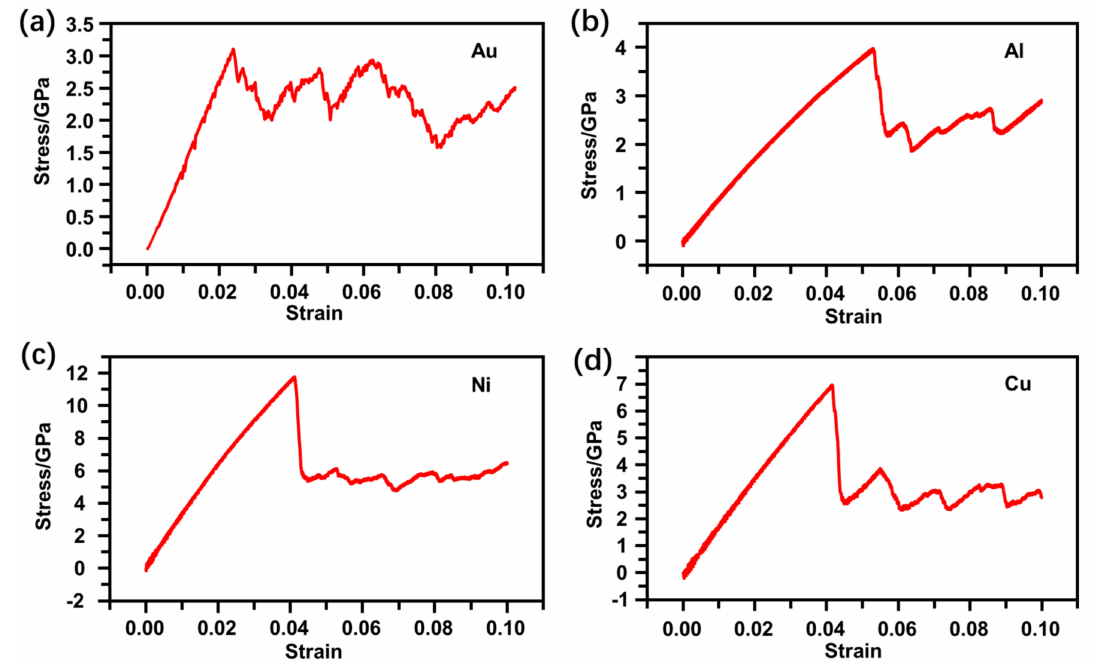
Figure 2. Stress–strain curves of ( a ) Au, ( b ) Al, ( c ) Ni, and ( d ) Cu nanocrystals with